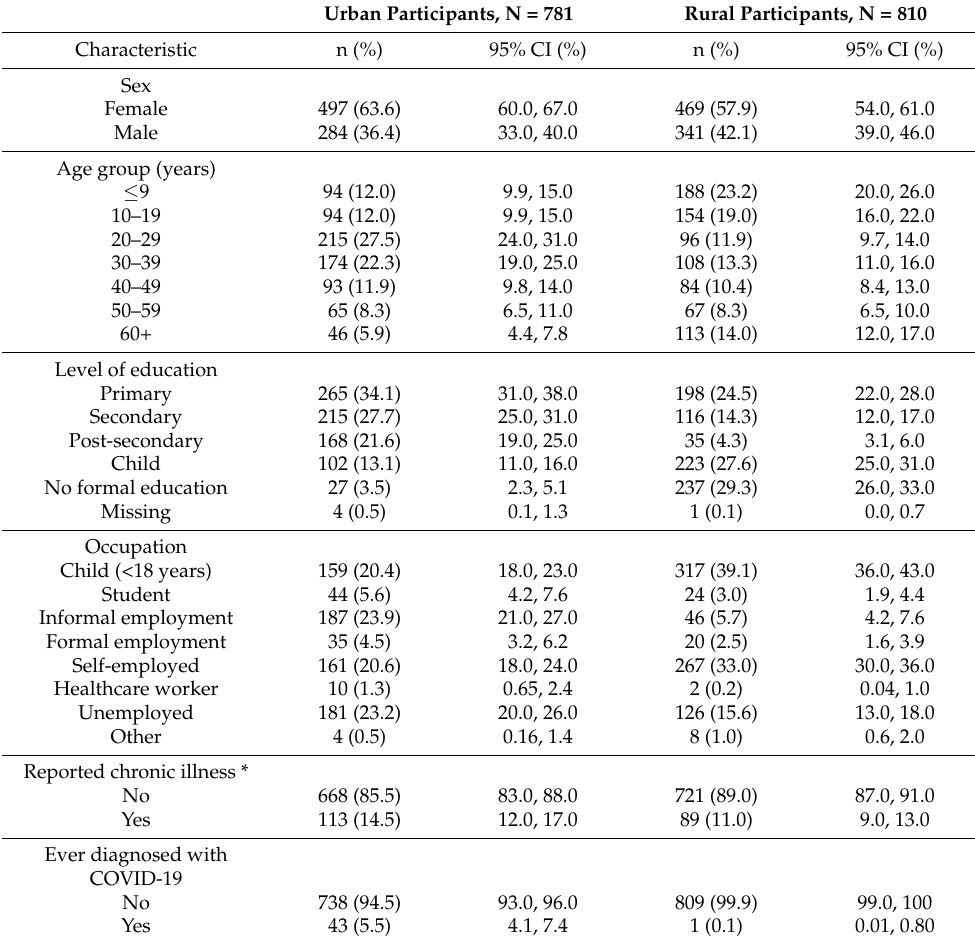
Table 1. Sociodemographic characteristics of all study